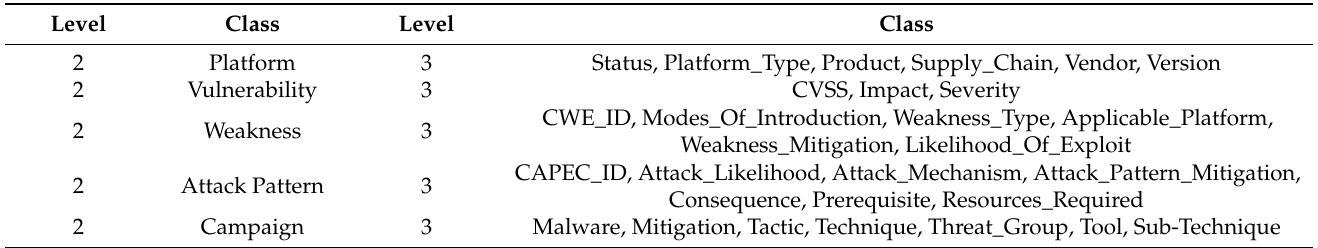
Table 1. Level 2 and level 3 ontology class